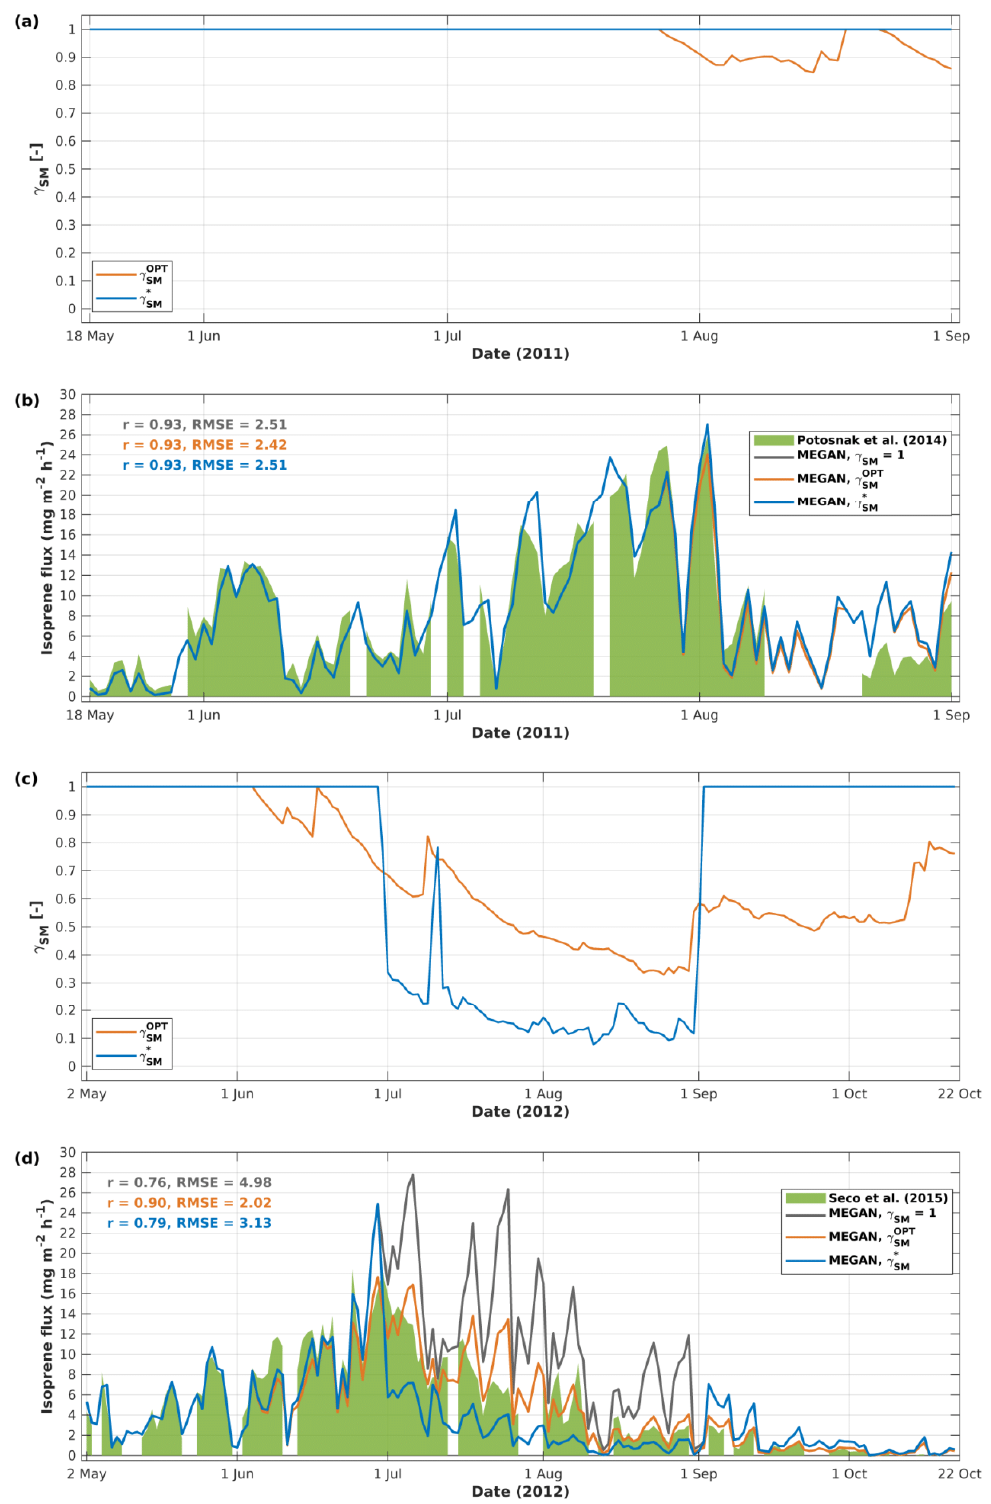
Figure 3. ( a ) Time series of the daily soil moisture stress activity factor in 2011 from 𝛾 (cid:3020)(cid:3014)(cid:3016)(cid:3017)(cid:3021) (orange) and 𝛾 𝑆𝑀∗ (blue); ( b ) Daily isoprene fluxes averaged over 7–17 h (CST) for 2011. Model results are shown for the cases 𝛾 (cid:3020)(cid:3014) = 1 (grey line), 𝛾 (cid:3020)(cid:3014)(cid:3016)(cid:3017)(cid:3021) (orange) and 𝛾 𝑆𝑀∗ (blue). The latter overlays the grey line since 𝛾 (cid:3020)(cid:3014)∗ = 1 over the entire period in 2011. ( c , d ): as ( a , b ), for 2012. Isoprene measurements (green shading) are from campaigns conducted in 2011 by [30] and in 2012 by [32].